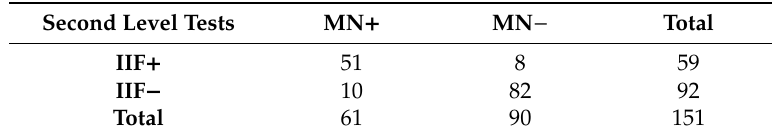
Table 4. Results obtained by indirect immunofluorescence assay (IIF) and microneutralization test (MN) in sera from 151 BDs that tested positive or borderline by